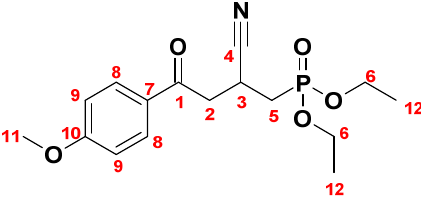
Figure 11. The structure of compound 5k .